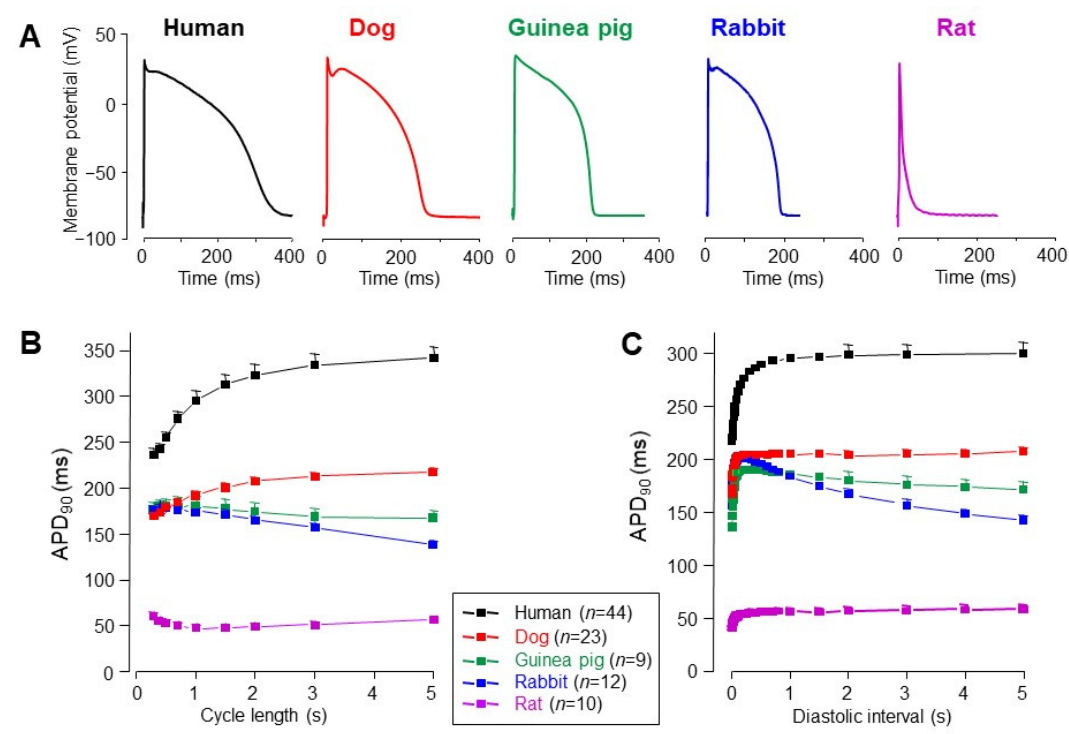
Figure 1. Action potential configurations ( A ), steady-state rate-dependent action potential durations at 90% of repolarization (APD 90 , ( B )), and APD 90 restitution relations ( C ) measured in multicellular human, canine, guinea pig, rabbit, and rat ventricular preparations using sharp 3 M KCl-filled microelectrodes. The restitution curves were obtained by gradually increasing the diastolic interval following a train of action potential stimulated at a stable cycle length. Symbols and bars are mean ± SEM values; ( n ) denotes the number of preparations studied